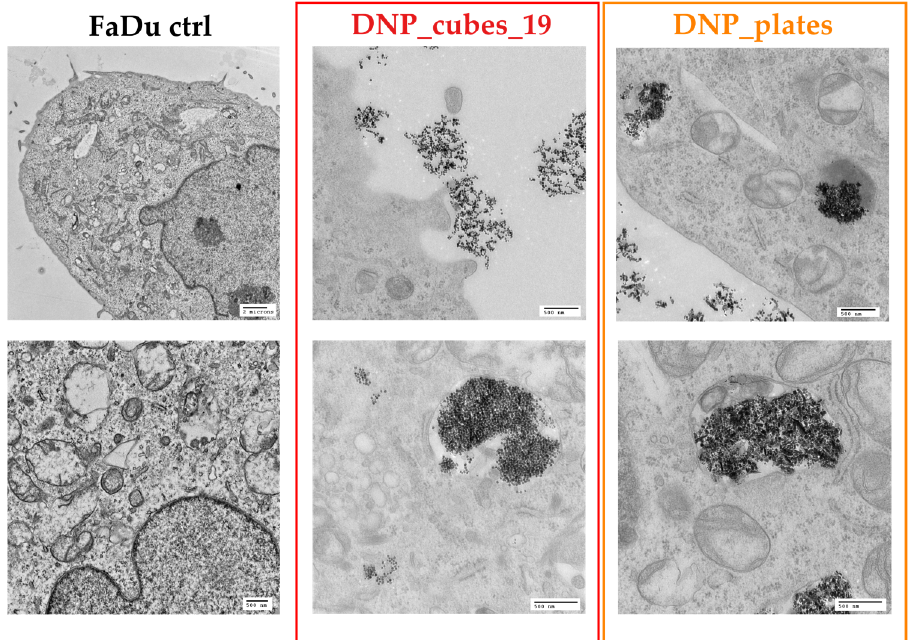
Figure 12. TEM images of FaDu control cells (left images), FaDu cells incubated with DNP_cubes_19 for 24 h at 100 µg/mL (images in the red square), and FaDu cells incubated with DNP_plates for 24 h at 100 µg/mL (images in the orange square).